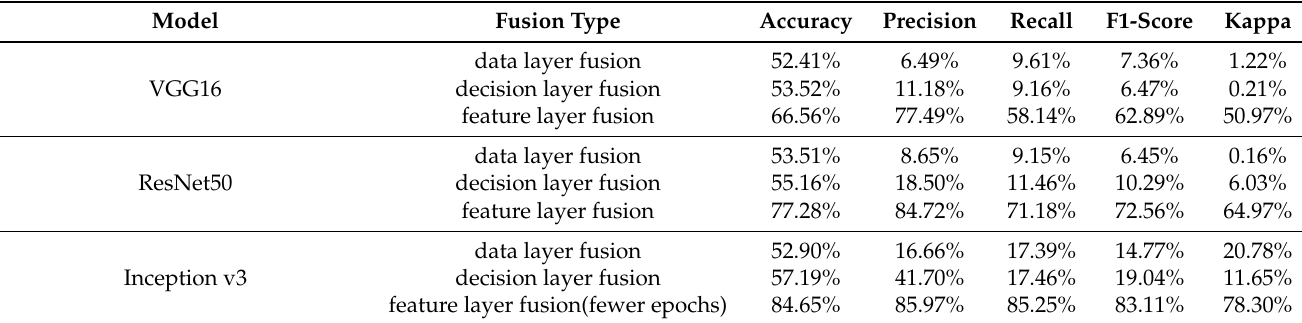
Table 7. Comparison of other fusion methods on more CNN-based